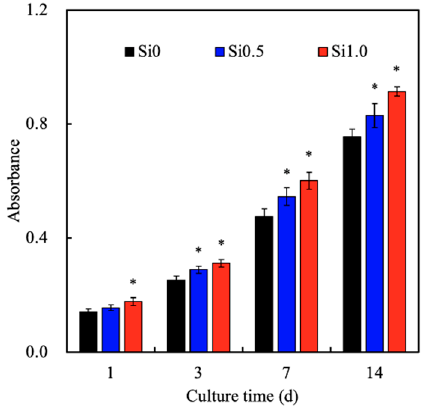
Figure 5. Proliferation rates on the various Si-GelMa hydrogels after different durations of immersion. * indicates significant difference (p < 0.05) from Si0.